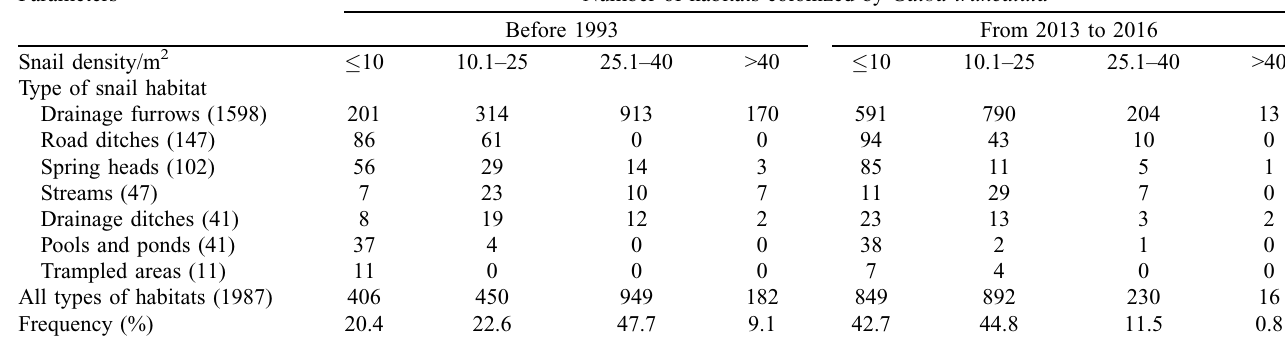
Table 5. Distribution of 1987 habitats colonized by Galba truncatula on the 162 farms before 1993 and in 2013–2016 in relation to the type of habitat and the number of overwintering snails counted in March or April. The total number of snail habitats is given after each type of habitat (first column).